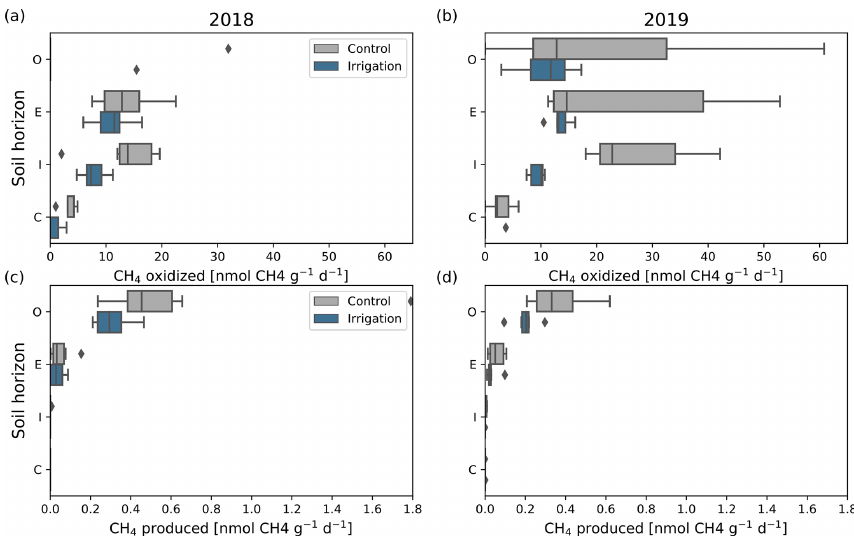
Figure 7. CH 4 oxidation (a, b) and production (c, d) potentials in different podzolic soil layers (organic layer, O, mean depth: 5.7cm; leaching layer, E, mean depth: 10.5cm; enrichment layer, I, mean depth: 18.9cm; bottom layer, C, mean depth: 32.3cm) in 2018 (a, c) and 2019 (b, d) ( n = 9). The boxes show the quartiles of the dataset and the vertical line inside the boxes is the median flux. Whiskers show the range of the data, except for the data that are determined to be outliers, which are shown with black